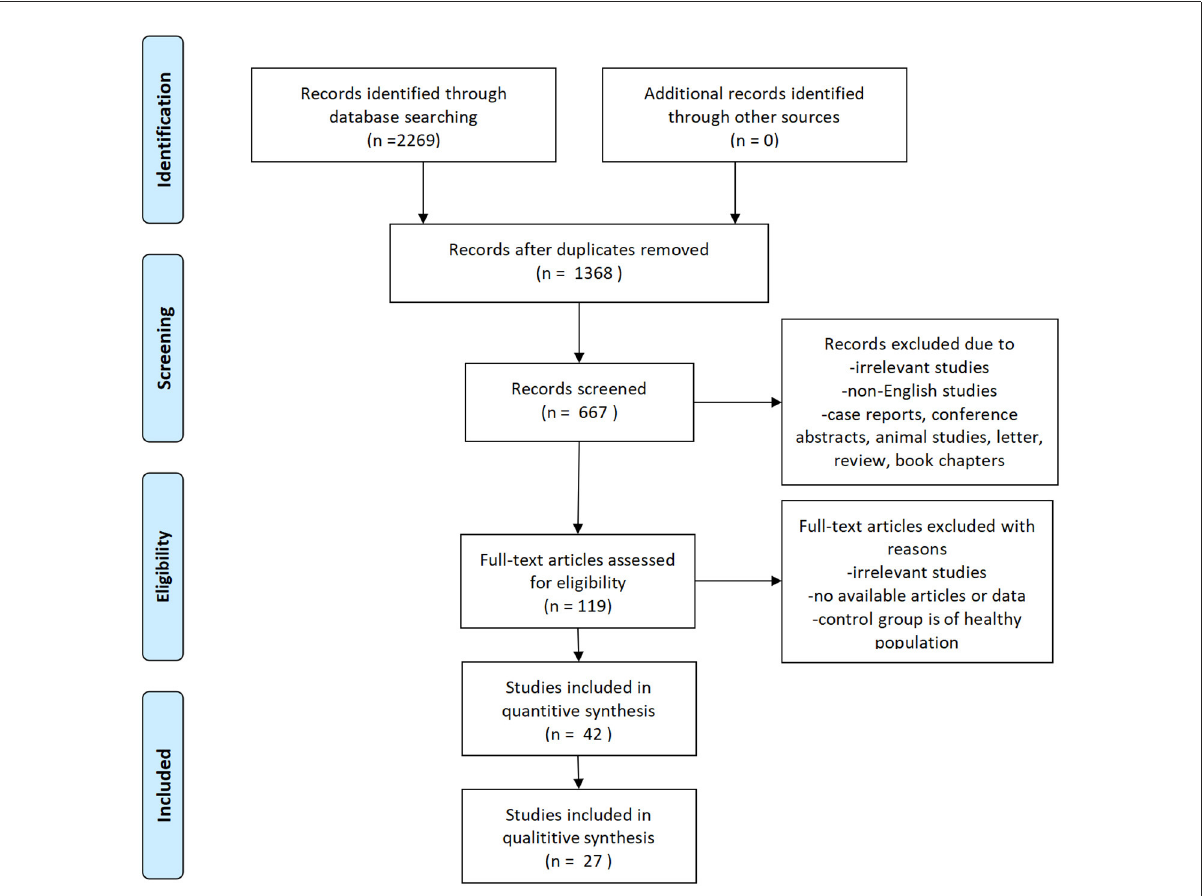
FIGURE1 Flow diagram of literature